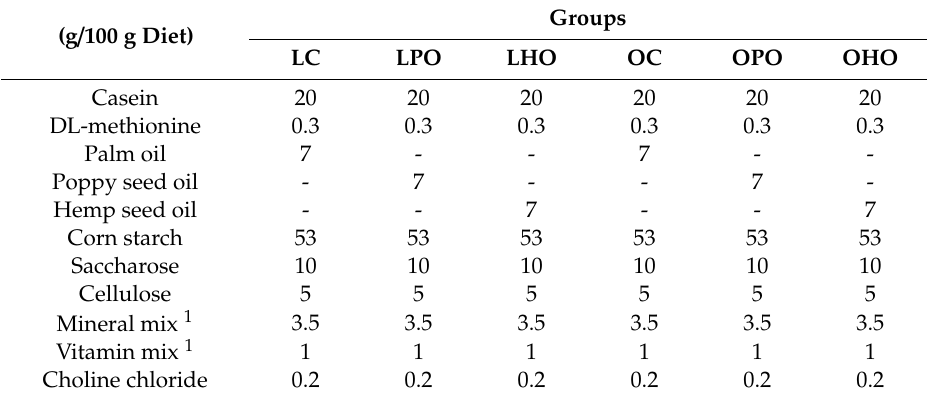
Table 5. Composition of the group-specific